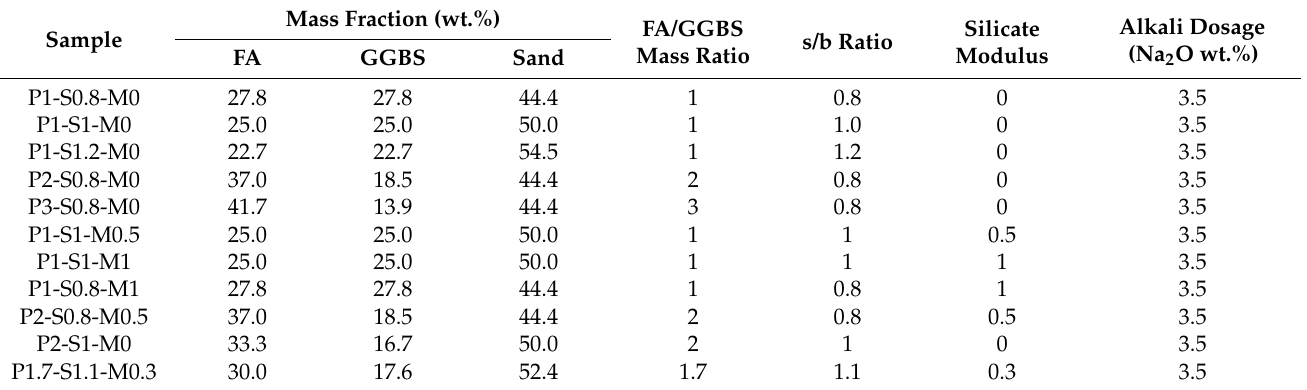
Table 2. Mix proportions of the AAFS mortars.